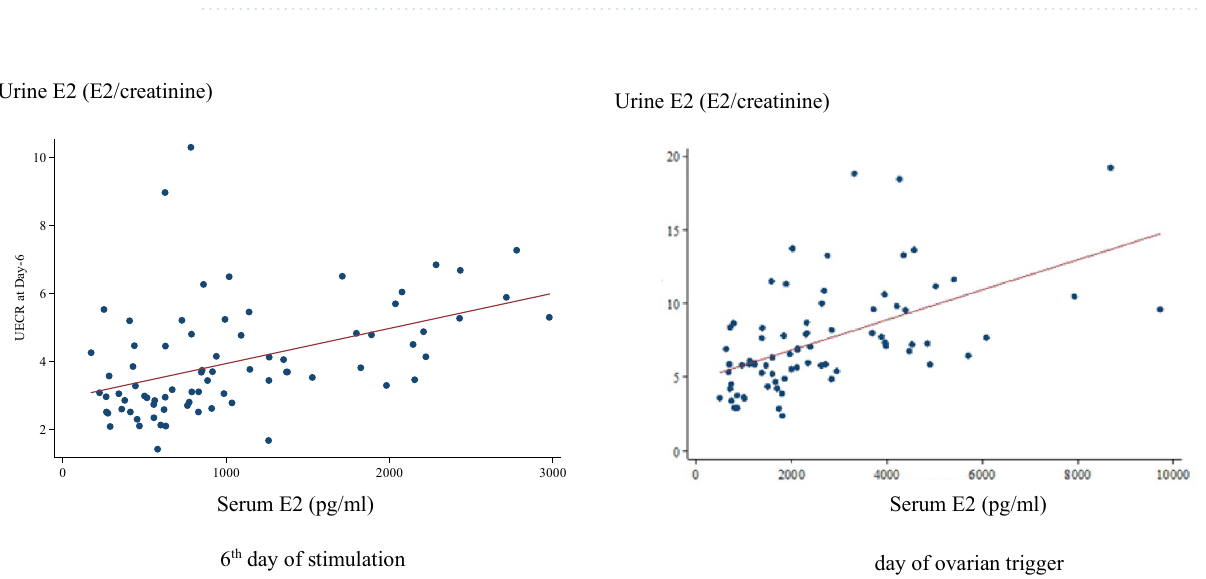
Table 2. Data distribution of urine and serum estradiol.